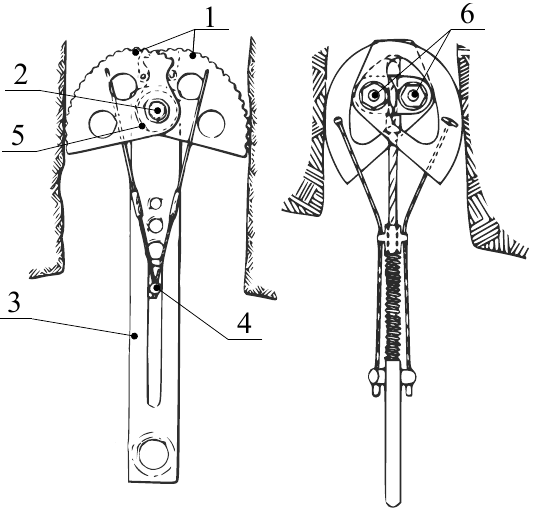
Figure 2. Single-axle SLCD patented by R. D. Jardine ( left ) [8] and dual-axle SLCD patented by T. Christianson ( right )